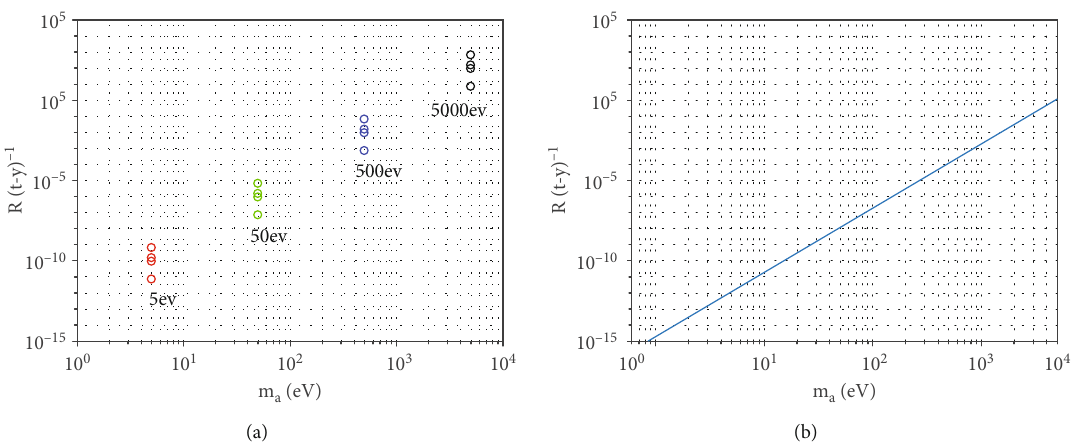
Figure 7: (a) Event rates for the last four states 4.31MeV, 5.24MeV, 5.74 MeV, and 5.97MeV of 23 Na (see Table 2) versus di ff erent axion masses. (b) The rate for axion photoproduction on 127 I. As expected, this is quite a bit smaller than in (a), due to the fact that the axion energy of 5.5MeV is much smaller than the nucleon mass. Note, however, that in this case, we have the extra signature of the produced photon. Since the rate is dominated by the coherent mode, the photon energy is approximately equal to the axion